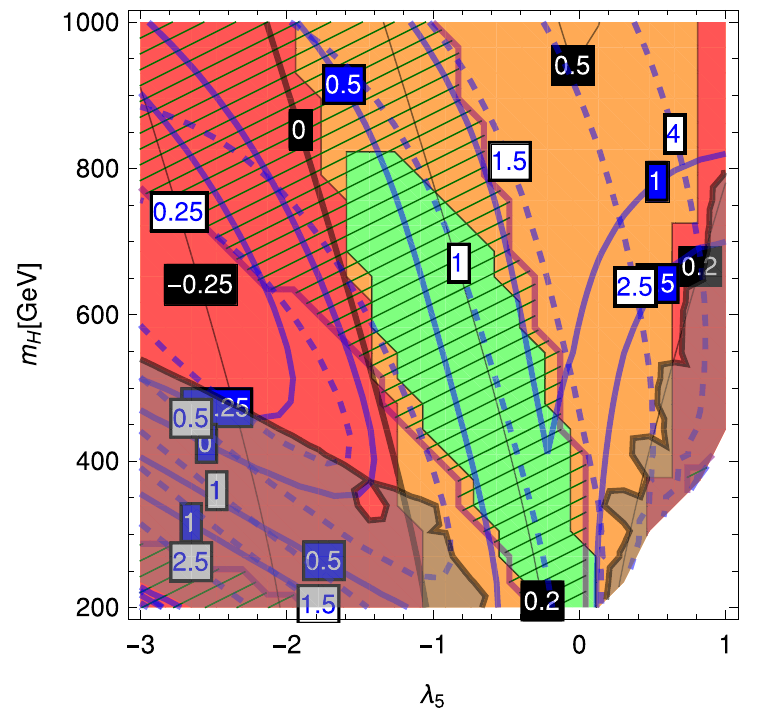
√ 2 λ 1 ( 2 λ 4 b + λ 3 b ), 2 λ 2 a + full blue ones of Min { 4 λ 2 a − | λ 5 a | + 4 √ λ + 2 λ (λ + 2 λ + λ + 4 (λ + λ )) − 1 λ − λ } . For 2 b 1 3 a 3 b 4 a 4 b 4 c 5 a 5 b 2 the dashed blue lines, the term of Eq. (4.26) was added in addition to the tree-level + CT potential and the UFB condition of 4 λ 2 a + λ 5 a + √ 4 2 λ 1 ( 2 λ 4 b + λ 3 b ) > 0 has been re-derived. The grey shaded area indicates the perturbativity constraints. The other parameter values are λ = 0 . 1, λ = 0 . 5, λ = − 0 . 1, α = 20 ◦ , s = 0 . H 2 3 4